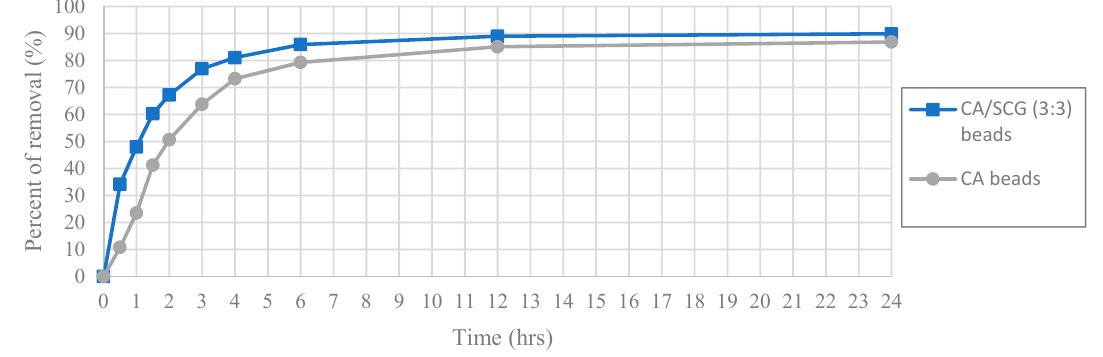
Figure 13. Plot of Percent of removal vs Time at initial concentration of 100 ppm of Cu 2+ , CA and CA-SCGs (3:3) beads.